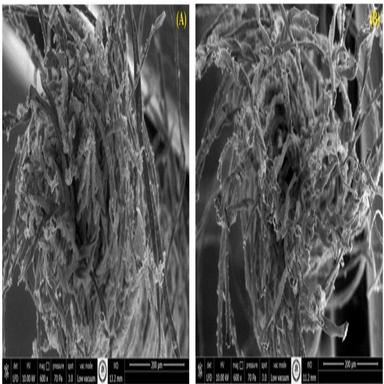
SEM images depicting cross-sections of PCM-Cott yarns produced at a feeding rate of 77.5 mL/h with different nanocapsule concentrations A: 3 % capsule concentration (Composition 1), and B: 9 % capsule concentration (Composition 2) (600 x).